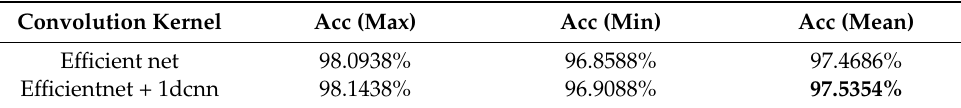
Table 5. Accuracy comparison results of the proposed methods.